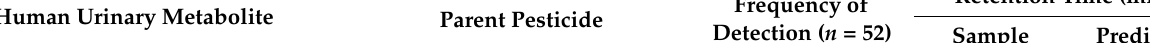
Retention Time (min.) Frequency of Detection ( n = 52)